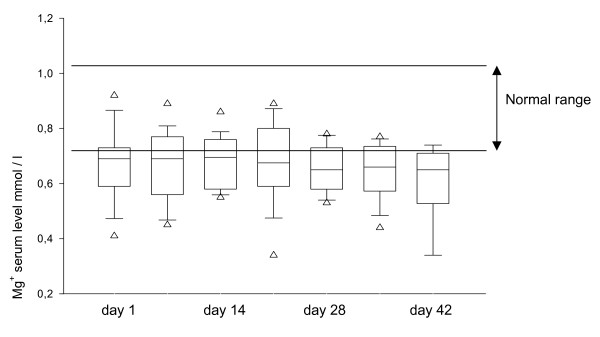
Boxplott of Magnesium serum levels. Day 1 after start of therapy to day 42.